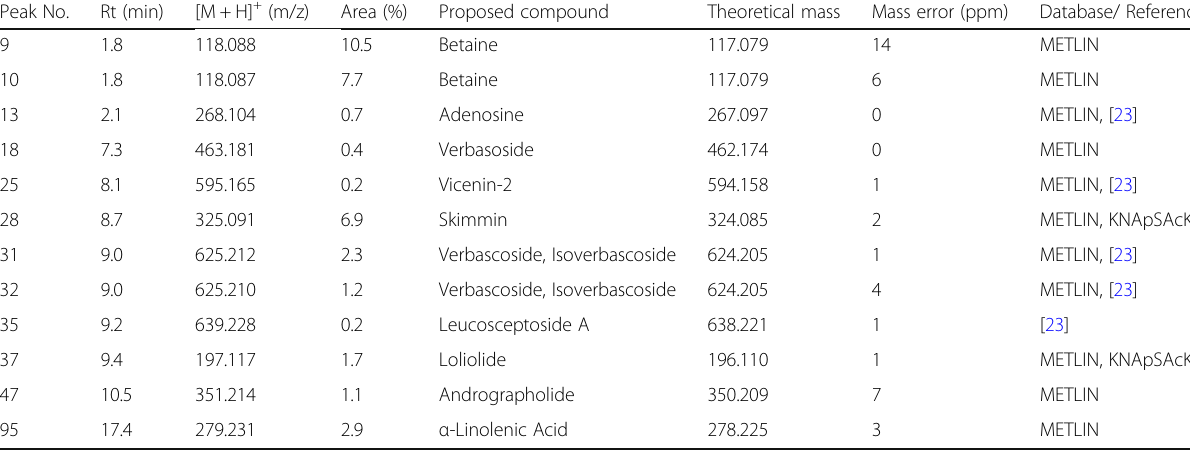
Table 2 Proposed phytochemical constituents in AEE Peak